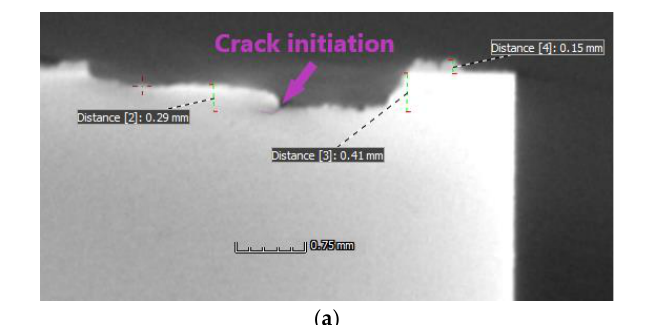
(SLM parameters are detailed in Section 2.2); ( b ) 3D reconstructions developed using CT images